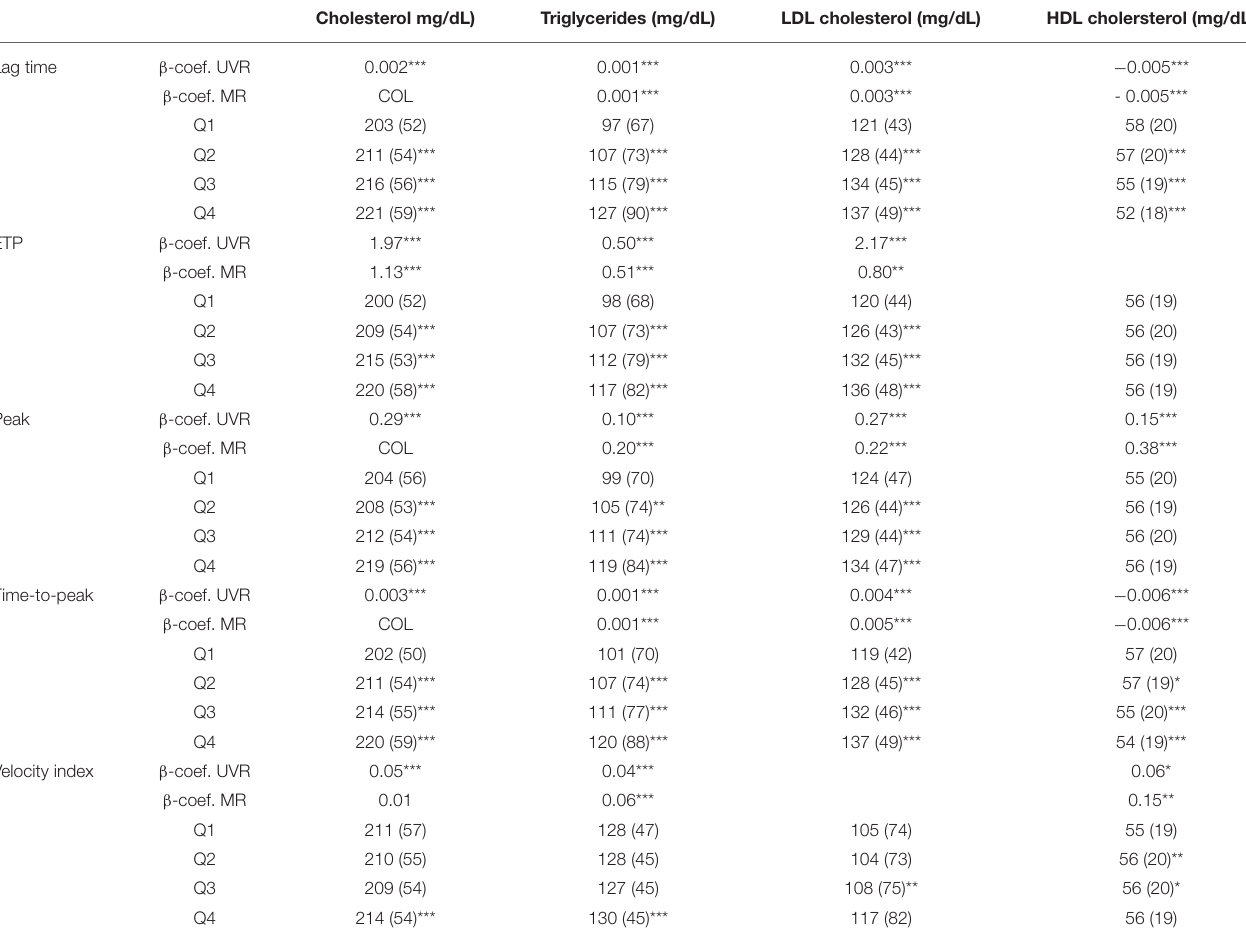
TABLE 3 | Linear regression and quartile analysis of lipid levels as determinants for TG parametersdetermined using PPP